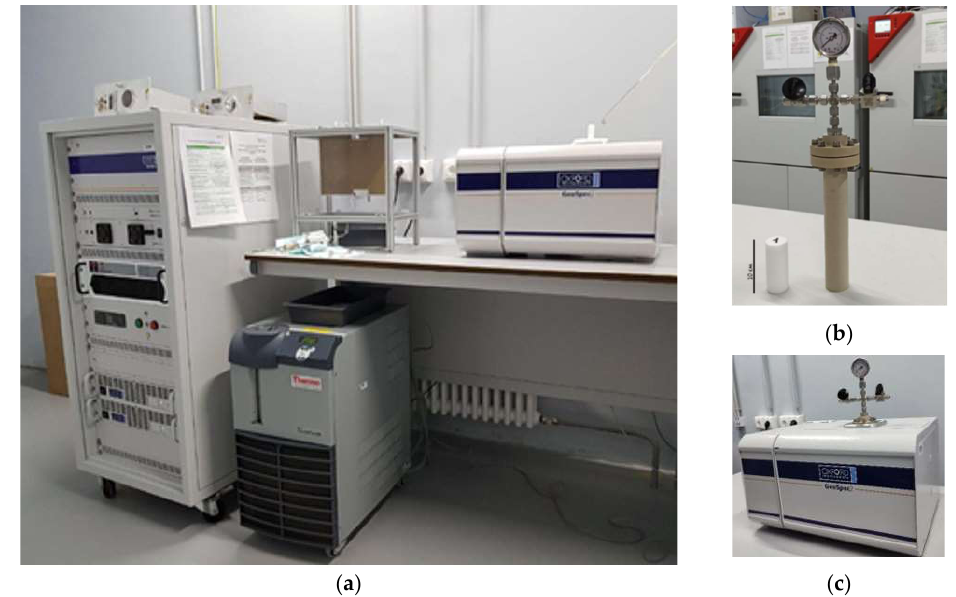
Figure 3. Oxford Instruments Geospec 2-53 Benchtop NMR Rock Core Analyzer (general view) ( a ); high-pressure core holder ( b ); core holder mounted on the NMR cell ( c